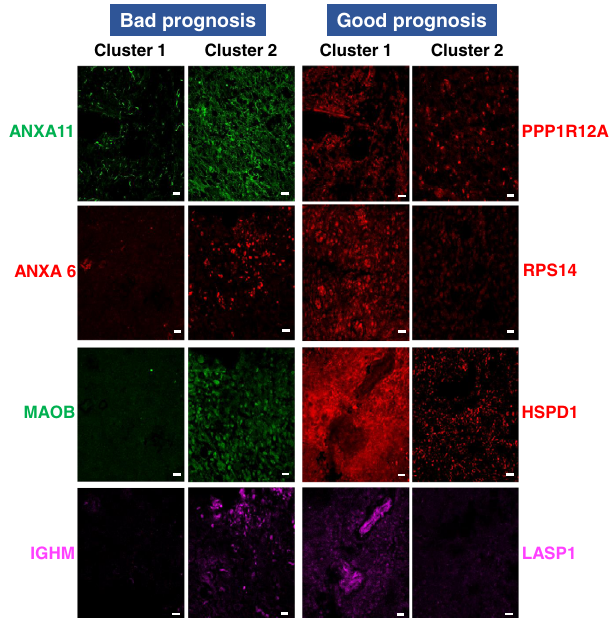
Fig. 4 | Validation immunohistochemistry of the panel of survival markers identi fi ed. Representative fl uorescence images of eight proteins in the two OS clusters of patients. Images were acquired with a confocal microscope at ×40 magni fi cation. The experiment was repeated on representative tissues of 23 patientsfortheprospectivecohortand onrepresentativetissuesof 50patientsfor the validation cohort. For each tissue, 3 – 4 images were taken for quanti fi cation. Scale bar=20 µ